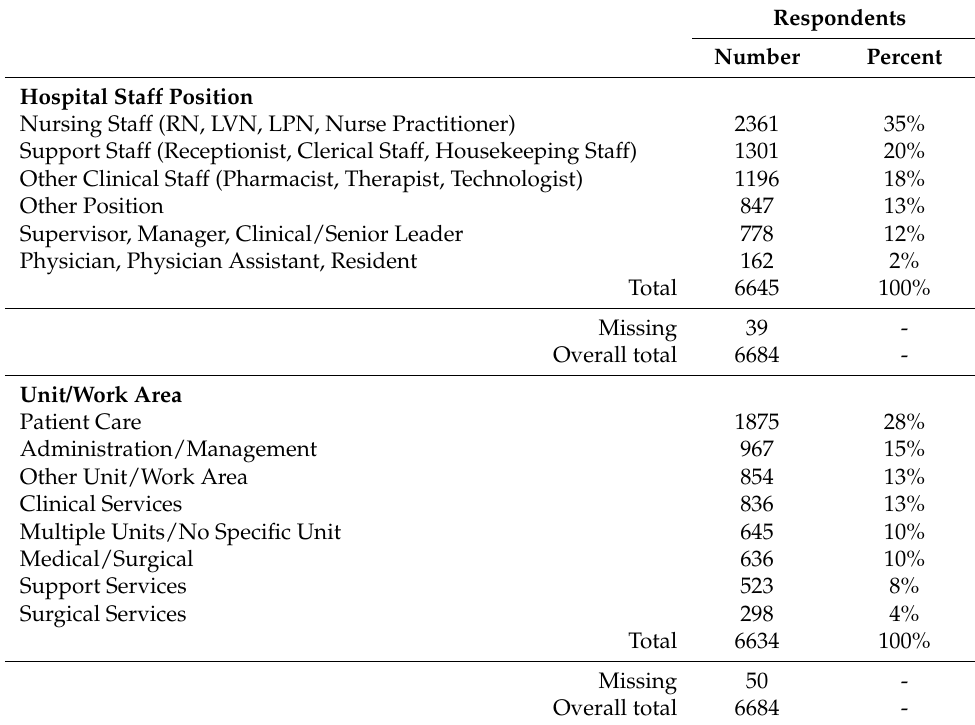
Table 4. Characteristics of respondents in pilot